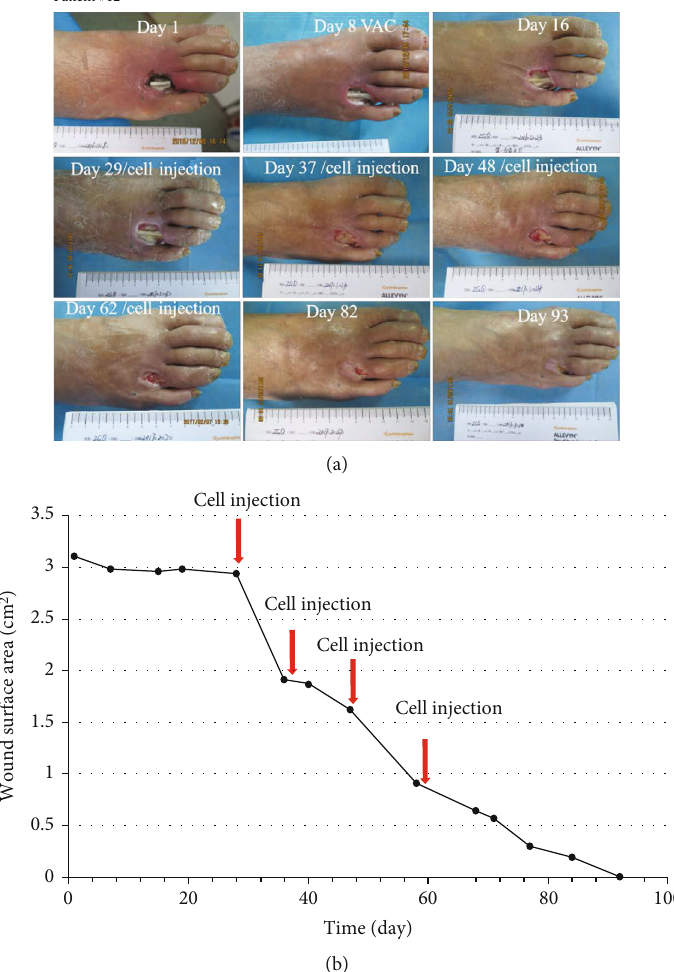
Figure 5: Photographs of ulcer before and after treatment (a) with depiction of wound surface area (b). Patient #12, a 69-year-old man with a 30-year history of type 2 diabetes, presented with infection of his right foot and exposed bones and tendons (Wagner 3), which was present for one week; the wound area was 3.10cm 2 after debridement of the